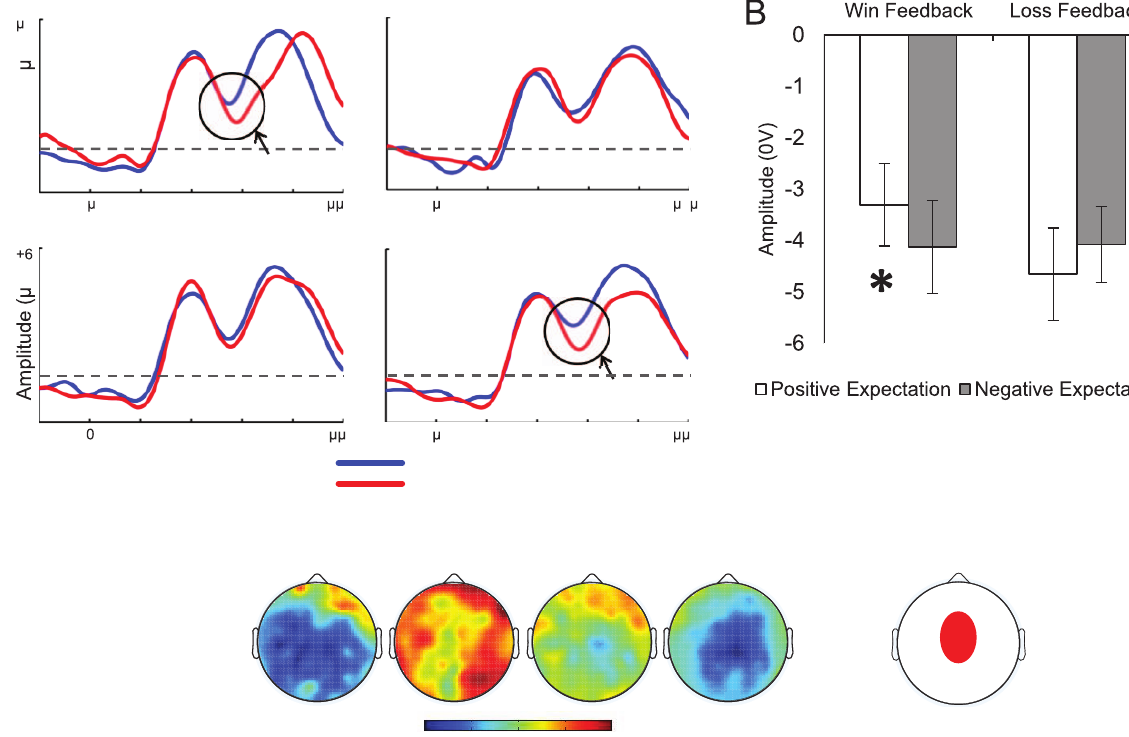
Figure 3. FRN data. Figure 3a. Averaged ERP waveforms for the Feedback-Related Negativity (FRN) plotting ERPs to Wins and Losses separately for the four experimental conditions. A 1–12 Hz bandwith was applied for presentational purposes. Figure 3b. Valence-specific comparisons of peak-to-peak amplitudes (in m V) between positive and negative expectancy contexts, separately for ERPs to Wins and Losses. Error bars represent one standard error from the mean. * p -value , .05. Figure 3c. Topographical maps plotting difference scores between Loss minus Win ERPs (peak to peak amplitudes) between 250 and 350 ms (maxima: + 1.0 m V, minima: 2 3.5 m V). Figure 3d. Scalp location of cluster of electrodes used to quantify the